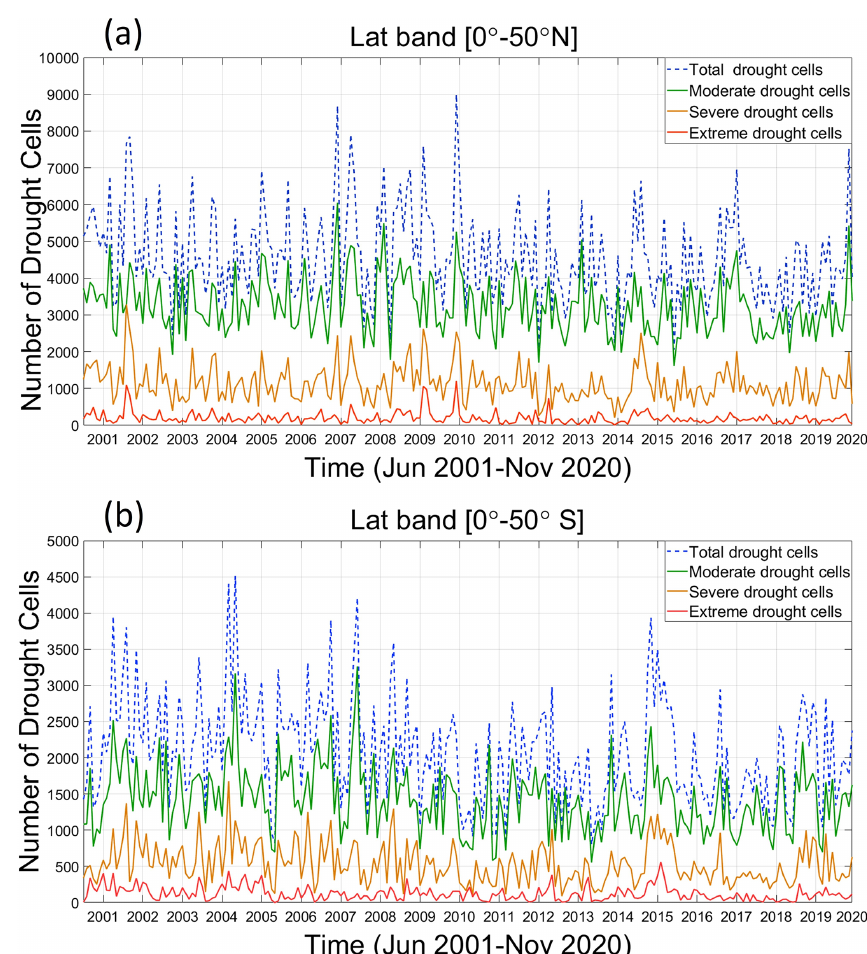
Figure 12. Number of cells covered with drought in (a) the NH and (b) the